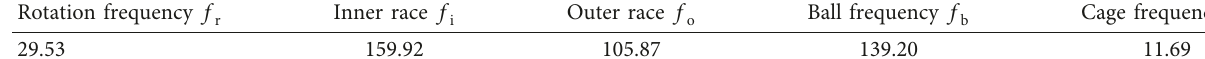
Table 3: Calculated characteristic frequencies of 6205-2RS (Hz).